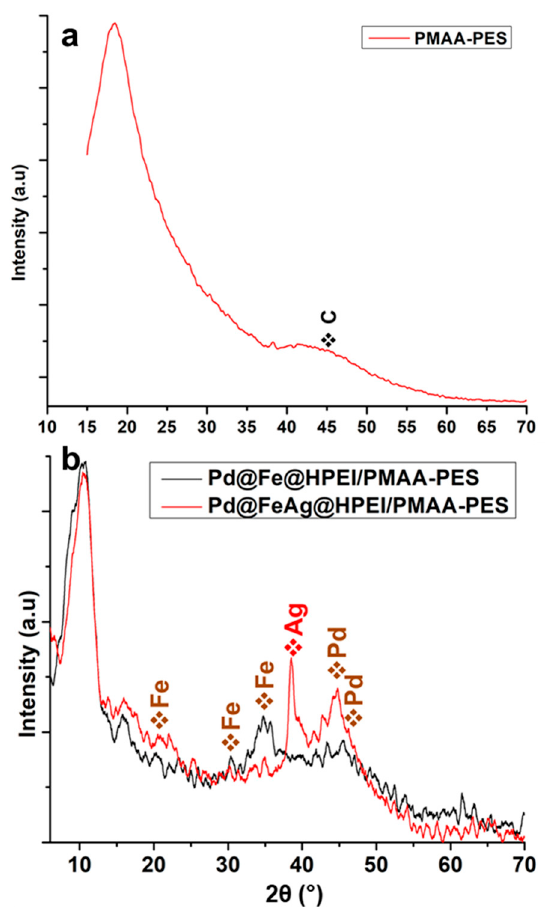
Figure 2. XRD spectra of the ( a ) PMAA-PES powder, and ( b ) the nanocomposites Pd@Fe@HPEI/PMAA-PES (black) and Pd@FeAg@HPEI/PMAA-PES (red). The Fe and Pd nanoparticles are labeled in brown since these are present in both nanocomposites. Ag is labeled in red for Pd@FeAg@HPEI/PMAA-PES.